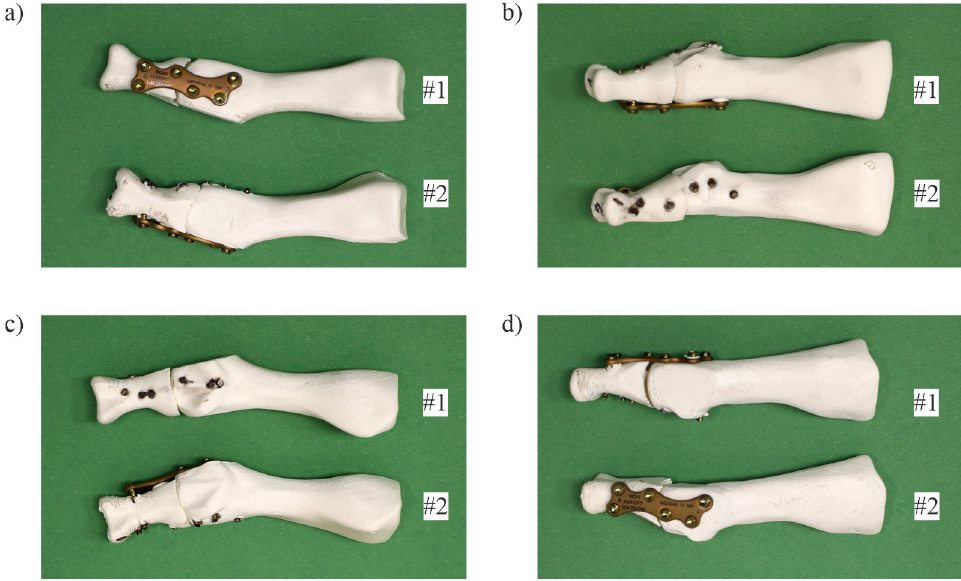
Fig 1. Tested samples (#1 –joint with a dorsally positioned plate and #2 –joint with a medially positioned plate): a) dorsal view; b) lateral view; c) plantar view; d) medial view.